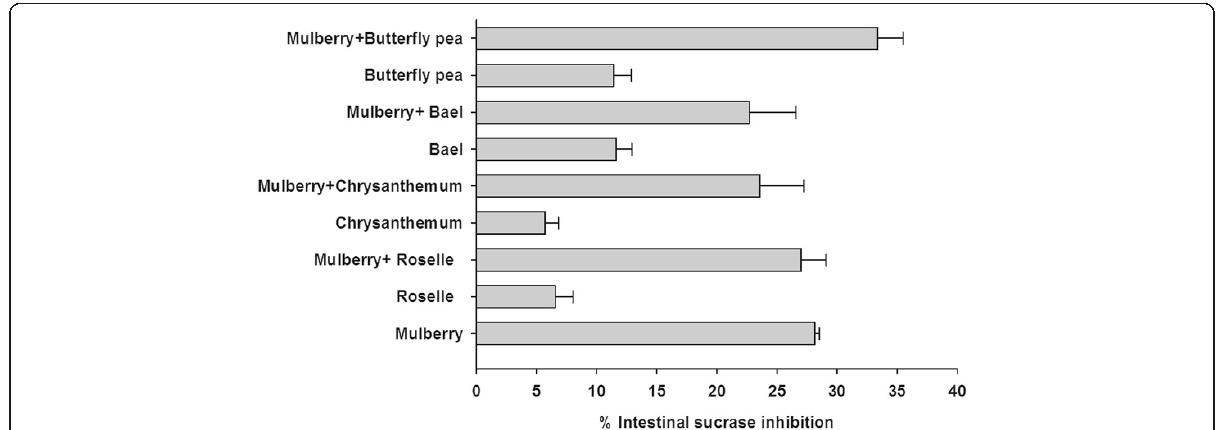
Figure 3 The percentage intestinal sucrase of combinatorial plant-based foods (0.2 mg/ml) with mulberry (0.2 mg/ml). The results are expressed as means ± S.E.M., n=3. *P < 0.001 compared to mulberry